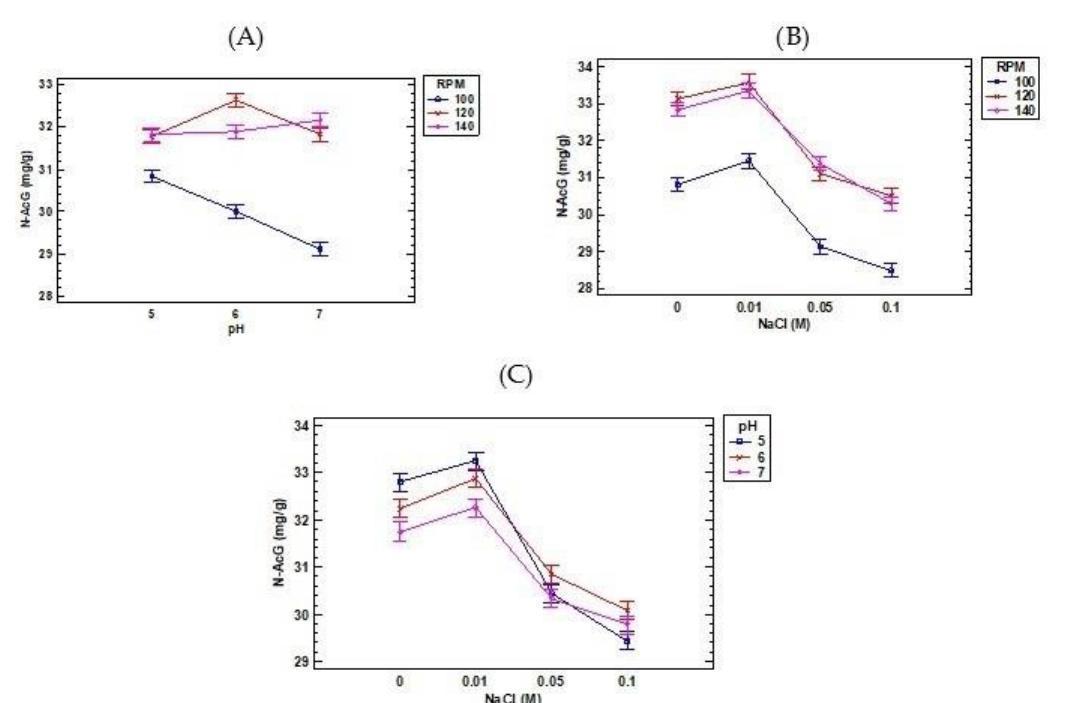
Figure 1. Interactions and 95.0 percent Tukey HSD intervals. The figure shows the interactions of pH and rpm ( A ), NaCl and rpm ( B ), and NaCl and pH ( C ) in relation to N-AcG production in mg/g dry matter. Table 4. Multiple range tests for N-AcG (mg/g) by NaCl (M). NaCl (M) Count LS Mean LS Sigma Homogeneous Groups 0.10 27 29.7666 0.046725 X 0.05 27 30.5383 0.046725 X 0.0 27 32.2596 0.046725 X 0.01 27 32.7961 0.046725 X